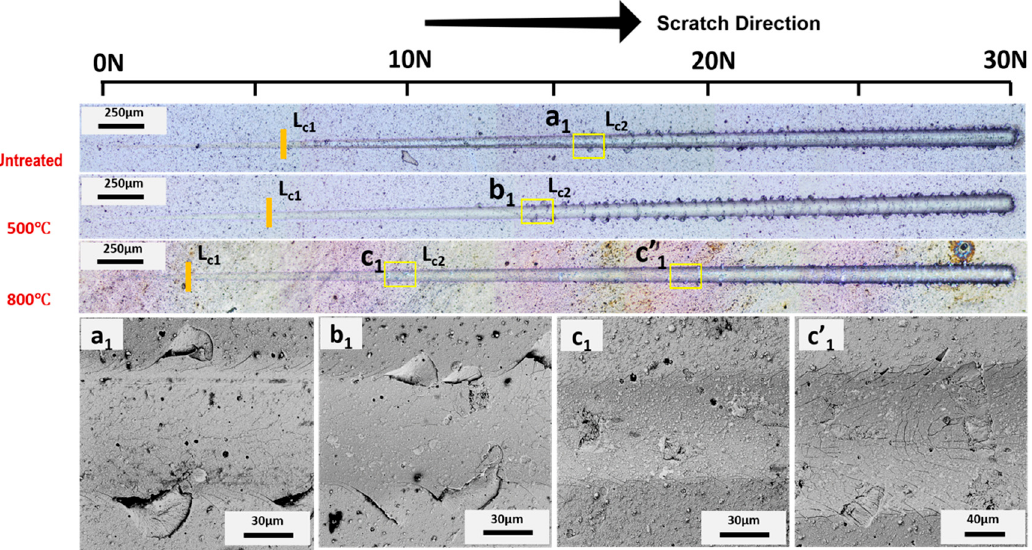
Figure 5 . Adhesion optical profile of failure after microscratch tests of the AlCrSiN/steel sample. First ( L c1 ) and second ( L c2 ) critical loads are indicated. SEM magnification of selected areas (a 1 , b 1 , c 1 and c’ 1 ) are also presented